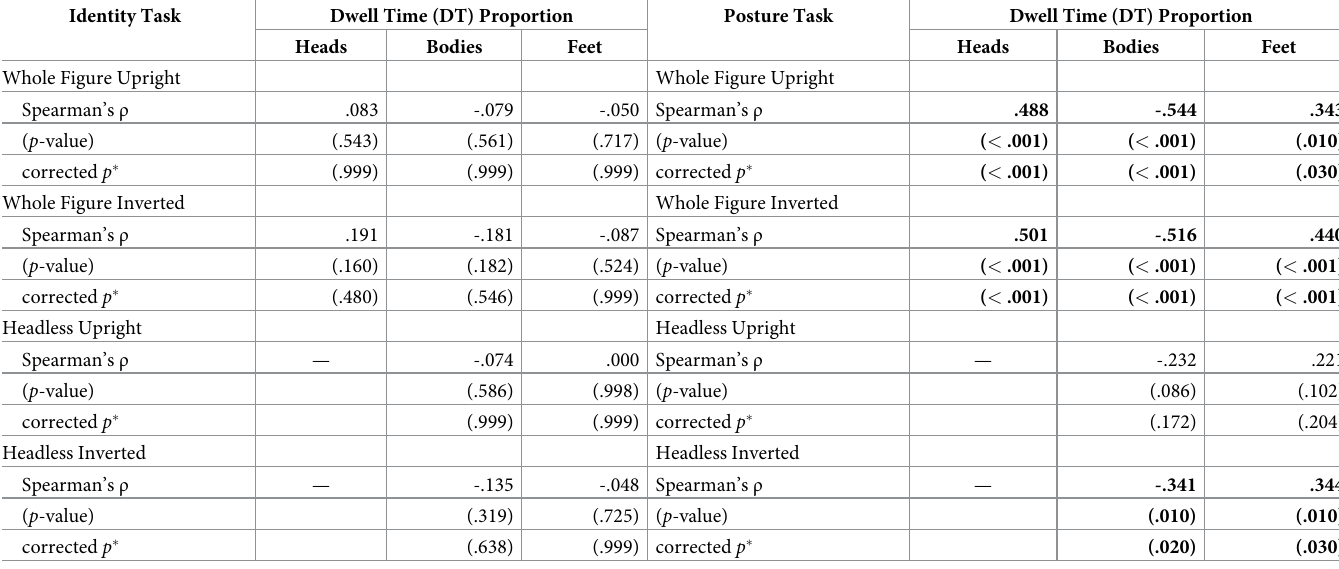
Table 5. Spearman’s ρ correlations between efficiency scores and proportional dwell time to heads, bodies, and feet. Identity